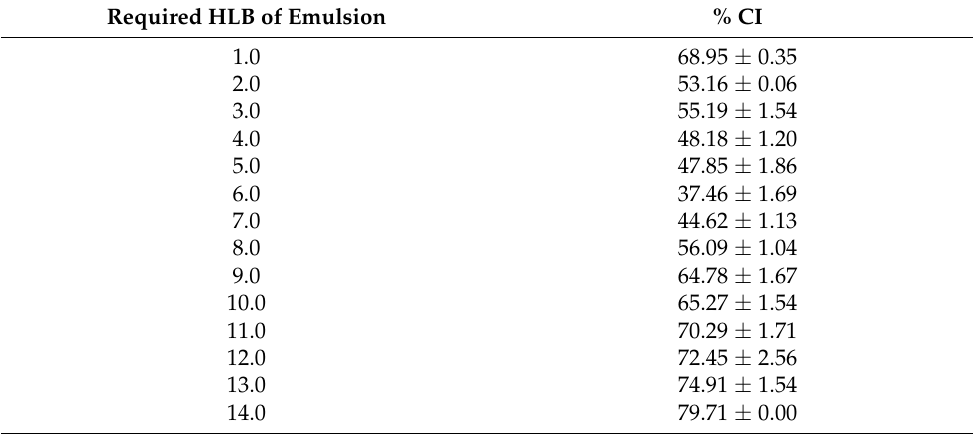
Table 7. Required HLB values 1.0–14.0 of emulsion and % CI.